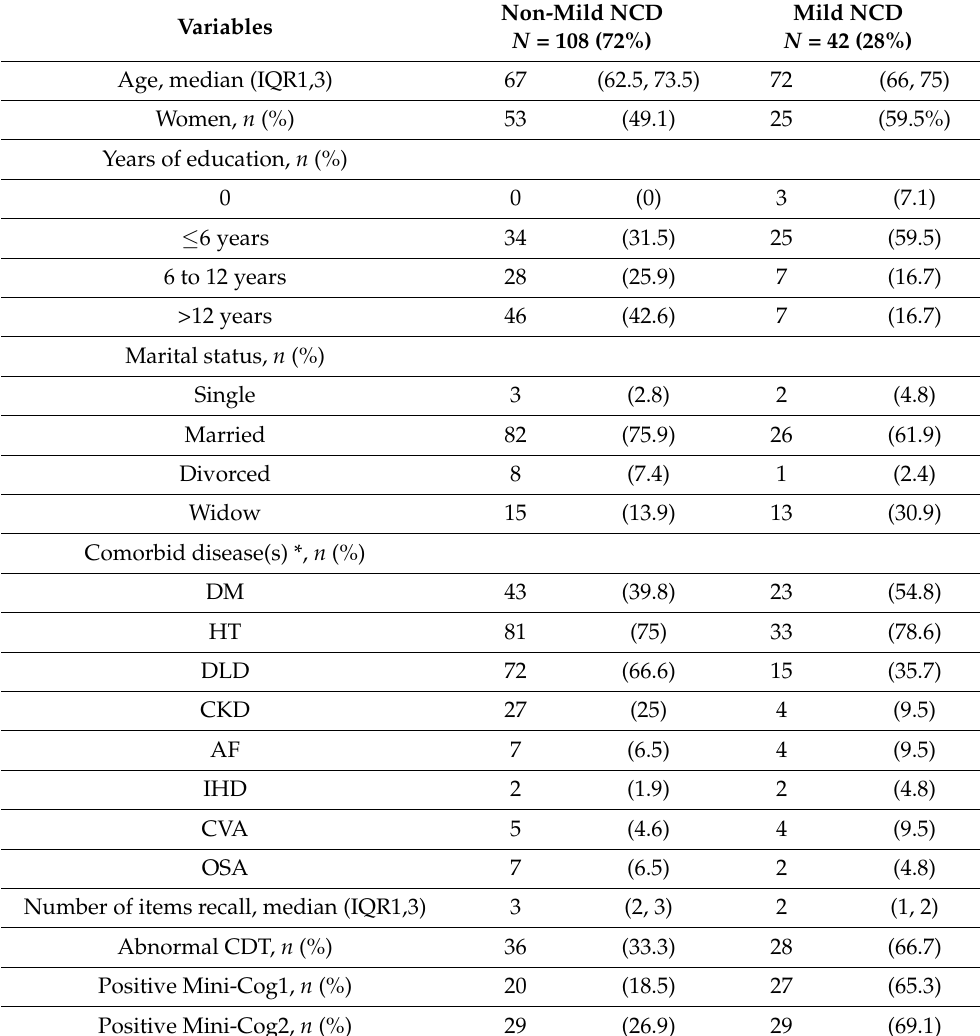
Table 1. Demographic and clinical characteristics of the